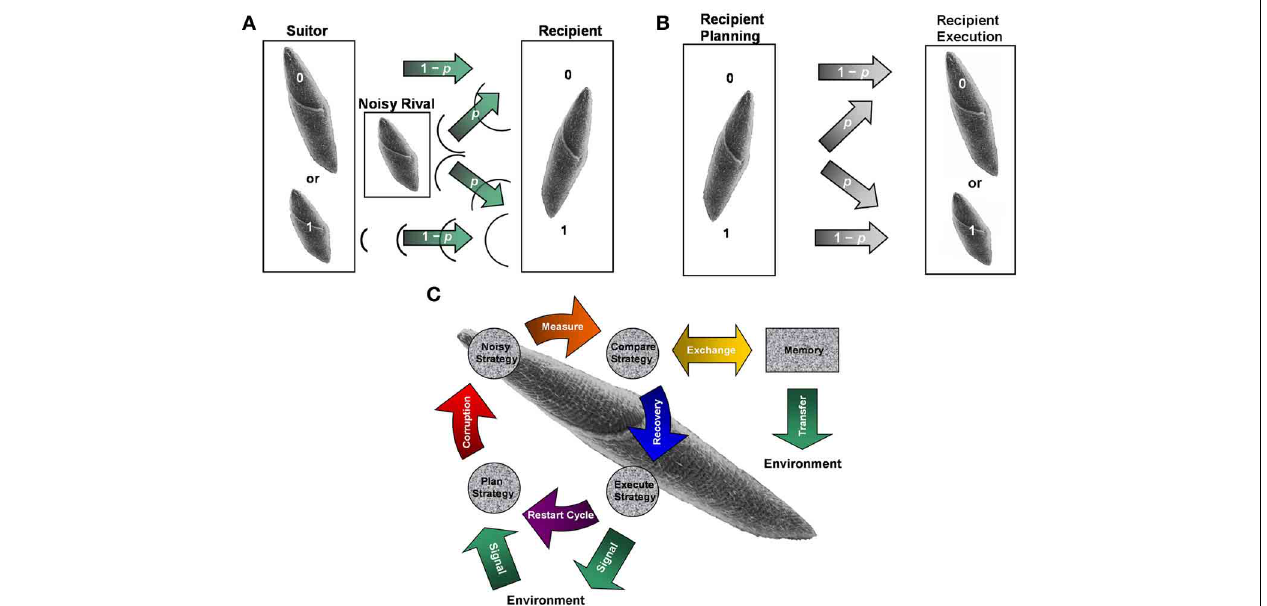
FIGURE 1 | Noisy communication channels, repetition coding, and Szilárd engine processing in ciliate signaling. (A) Example of noisy binary symmetric bit-flip channel interfering with suitor contraction messages. An S. ambiguum suitor either contracts (1) or remains fully extended (0) with probability 1 − p of respectively sending or not sending a single courting vibration without error to a recipient S. ambiguum . A noisy S. ambiguum rival positioned between suitor and recipient emits a single contraction with a probability p of corrupting the suitor’s message. Vibration from rival’s contraction may collide with suitor’s vibration, annihilating both signals and flipping the courting signal from 1 to 0. Or, vibration from rival’s contraction may pass to the recipient when suitor remains fully extended, flipping the courting signal from 0 to 1. The rival’s behavior is a form of social cheating, where it takes advantage of its closer physical proximity to the recipient to attract (e.g., bit flip from 0 to 1) and conjugate (e.g., bit flip from 1 to 0) a mating partner already “aroused” by the suitor’s previous actions. Suitors may improve upon the reliability of single-contraction signals by sending a series of three binary responses (e.g. (1,1,1) for conspicuous consumption and (0,0,0) for prudent savings), known as repetition coding. As long as no more than one bit flip occurs in the response series, the message is transferred and decoded successfully at probability p < 1 / 2. When p exceeds this value, the probability of error becomes p E = 3 p 2 − 2 p 3 > p and signal transmission loses its